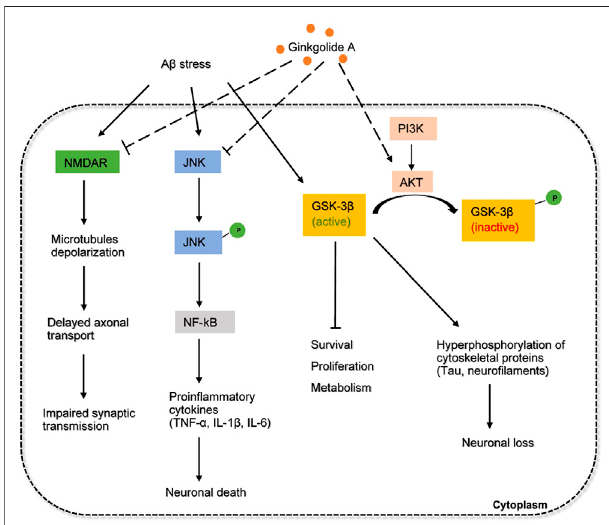
FIGURE 4 | The inferred mechanism of ginkgolide A in AD pathology. The drug acts through the inhibition of NMDA receptor, JNK signaling and the activation of PI3K-AKT pathway. Inhibition of NMDA receptor prevents excessive amounts of glutamate that are associated with synaptic dysfunctionandtauphosphorylation.InhibitionofJNKpathwaydecreasesthe production of proin fl ammatory cytokines involved in neuroin fl ammation. Activation of PI3K-AKT pathway strengthens the inhibition of GSK3 β and furtherpreventsthehyperphosphorylationoftauproteins. Thesoliddashlines show the interactions of protein kinases and signaling cascades. The long- dashed lines show the pharmacological action of the drug.